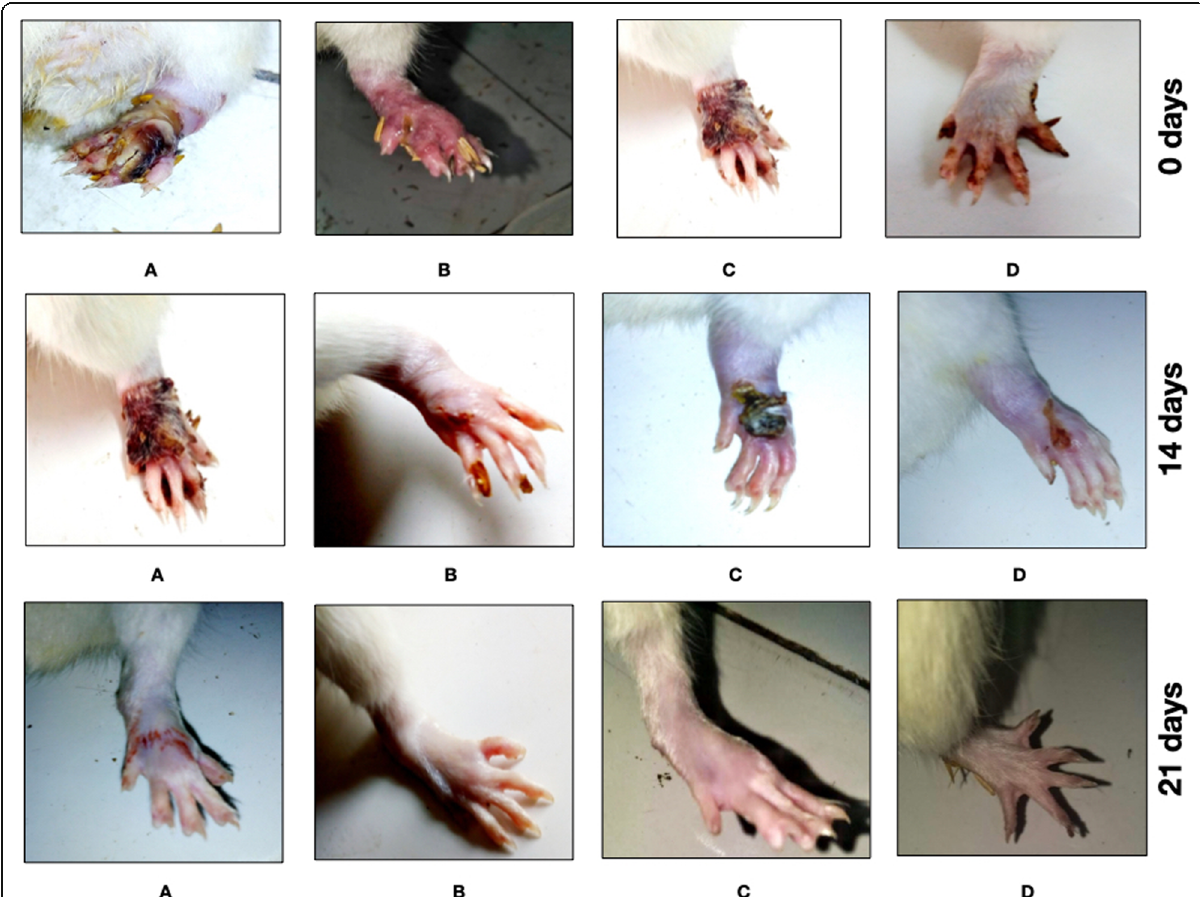
Fig. 3 X-ray images of CPL induced paw edema in rats. a = Control group, b = Low dose group (200 mg/kg), c = High dose group (400 mg/kg), d =